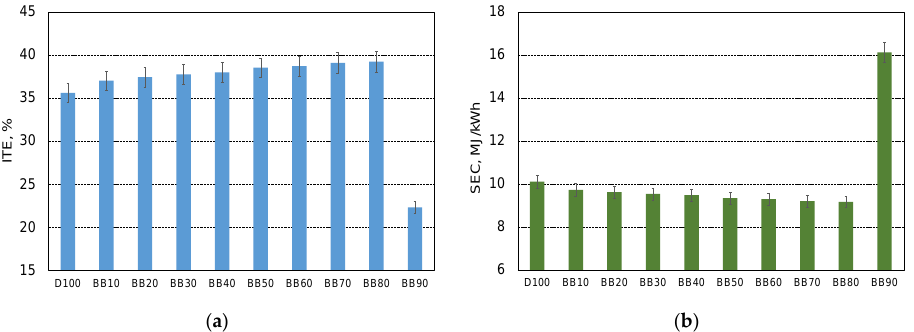
Figure 6. Indicated thermal efficiency (ITE) ( a ) and specific energy consumption (SEC) ( b ).